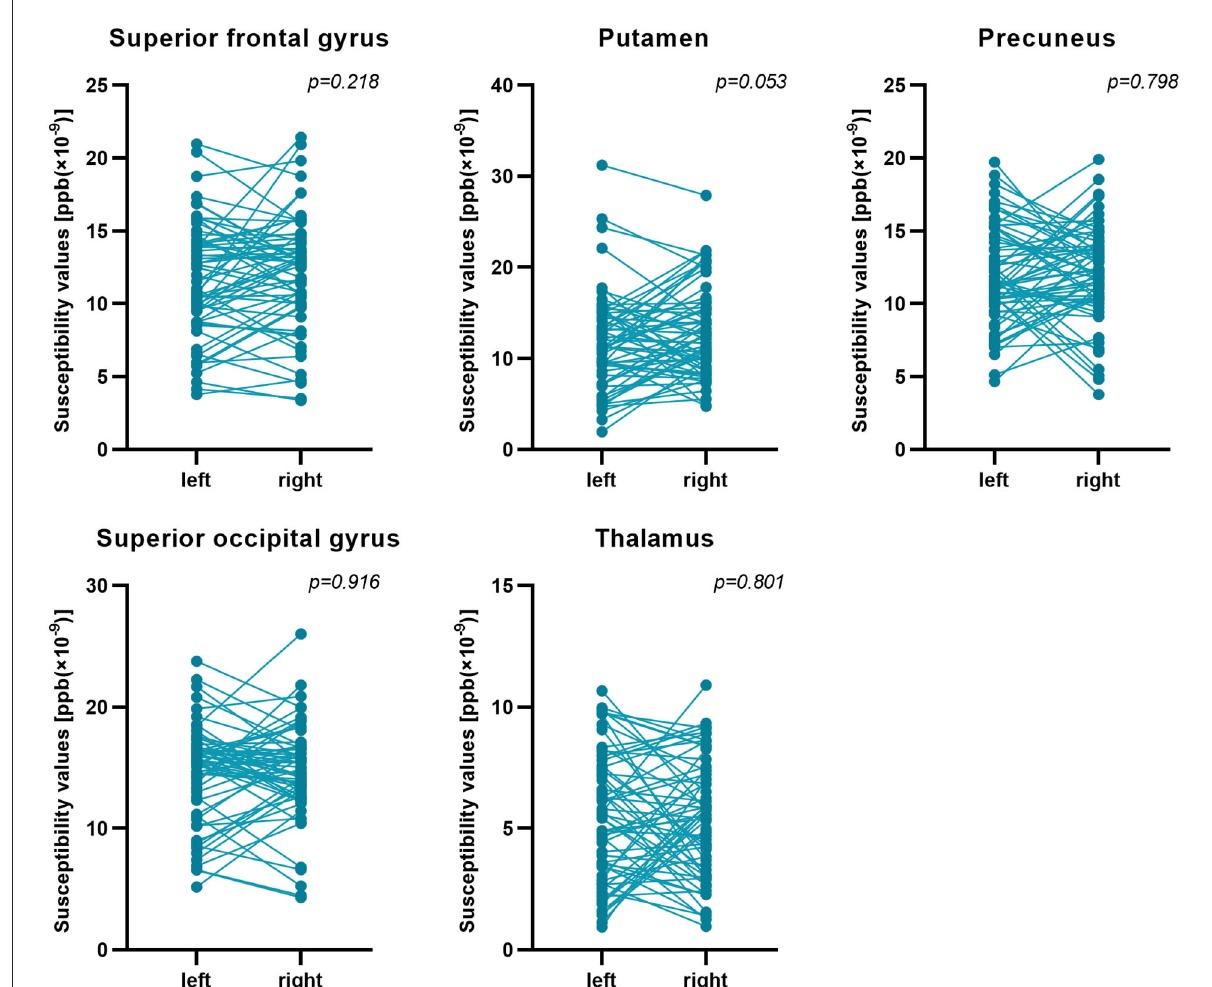
FIGURE4 Susceptibility values of bilateral hemispheres. Comparison of the susceptibility values of all participants’ bilateral hemispheres by paired t- test. There was no significant difference between them.